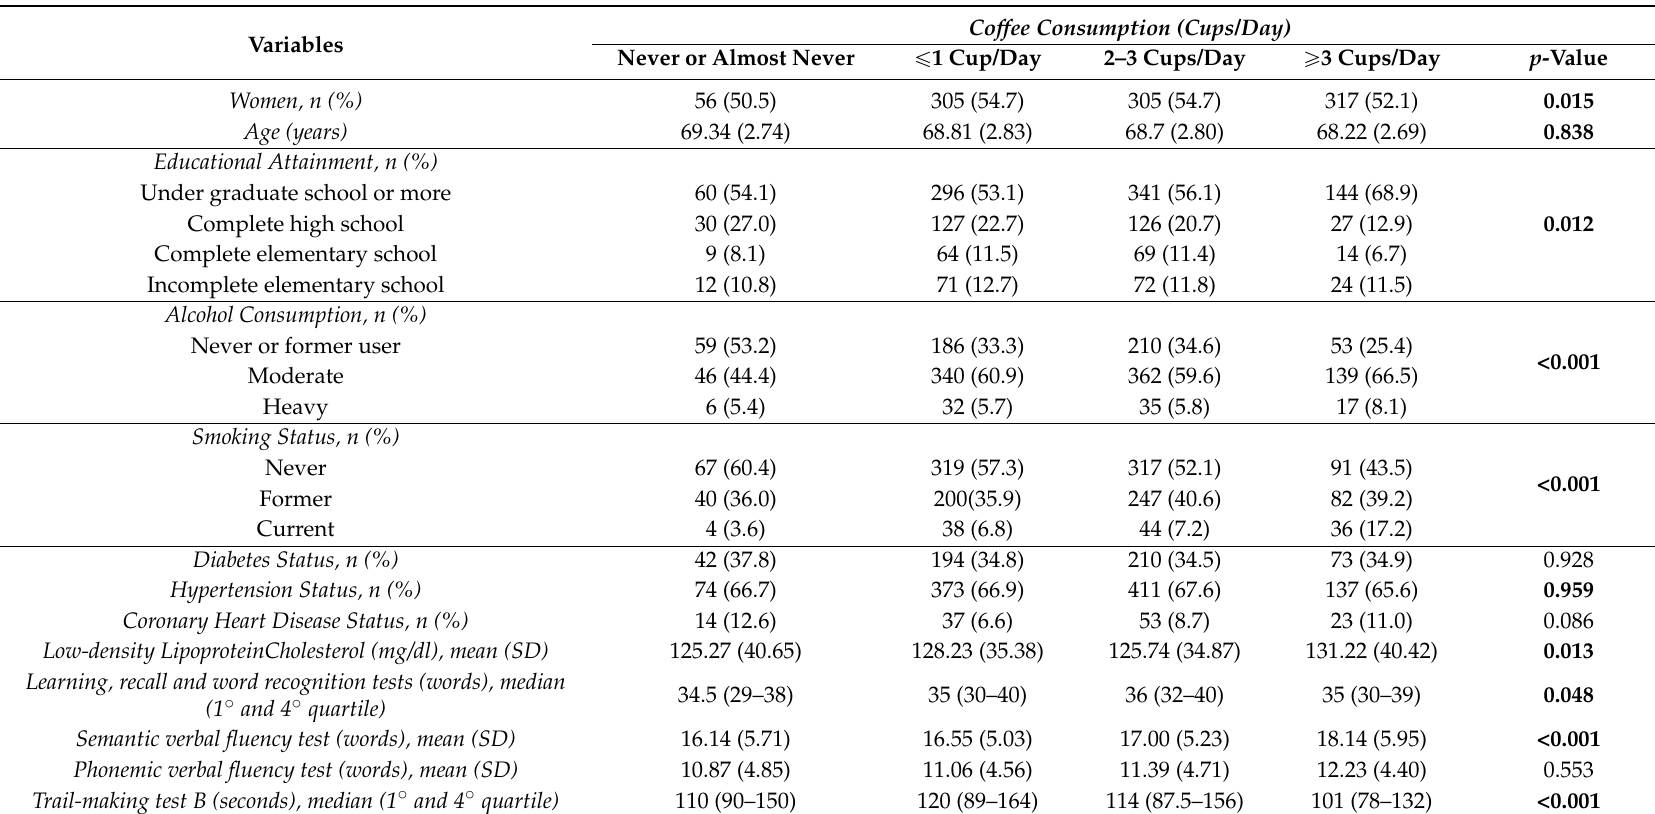
Table 2. Characteristics of the study population (65–74 years old) of ELSA-Brasil